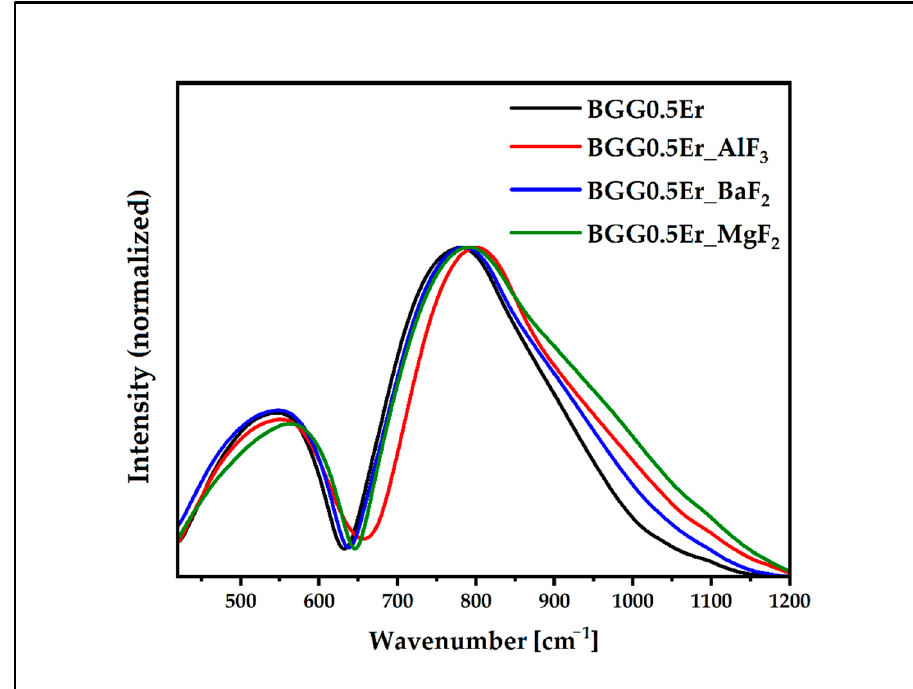
Figure 3 . Normalized IR spectra of glasses in the 420 cm − 1 –1200 cm − 1 range. Figure 3. Normalized IR spectra of glasses in the 420 cm − 1 –1200 cm − 1